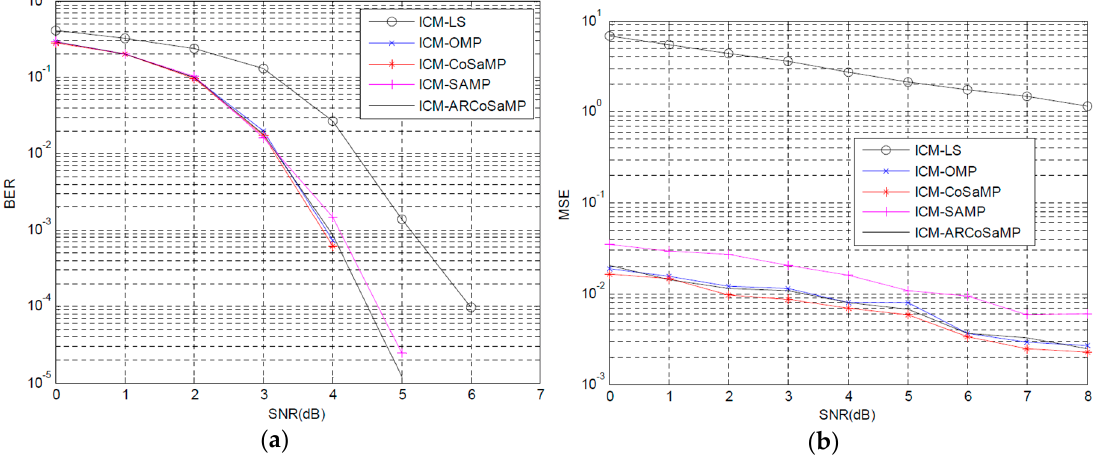
Figure 6. BER and MSE performance comparison based ICM preamble structure: ( a ) BER and ( b ) MSE.